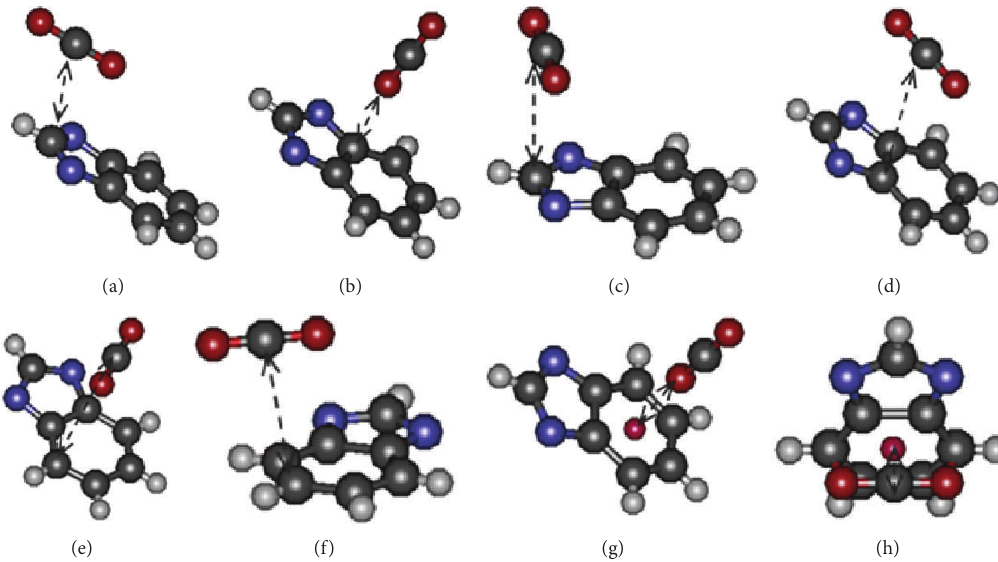
Figure 2: The possible configurations of CO 2 –[C 7 H 5 N 2 ] − complexes used to determine the ab initio binding energies.